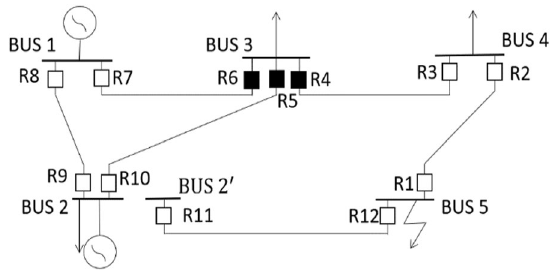
Fig. 4 5-bus system with busbar splitting scheme